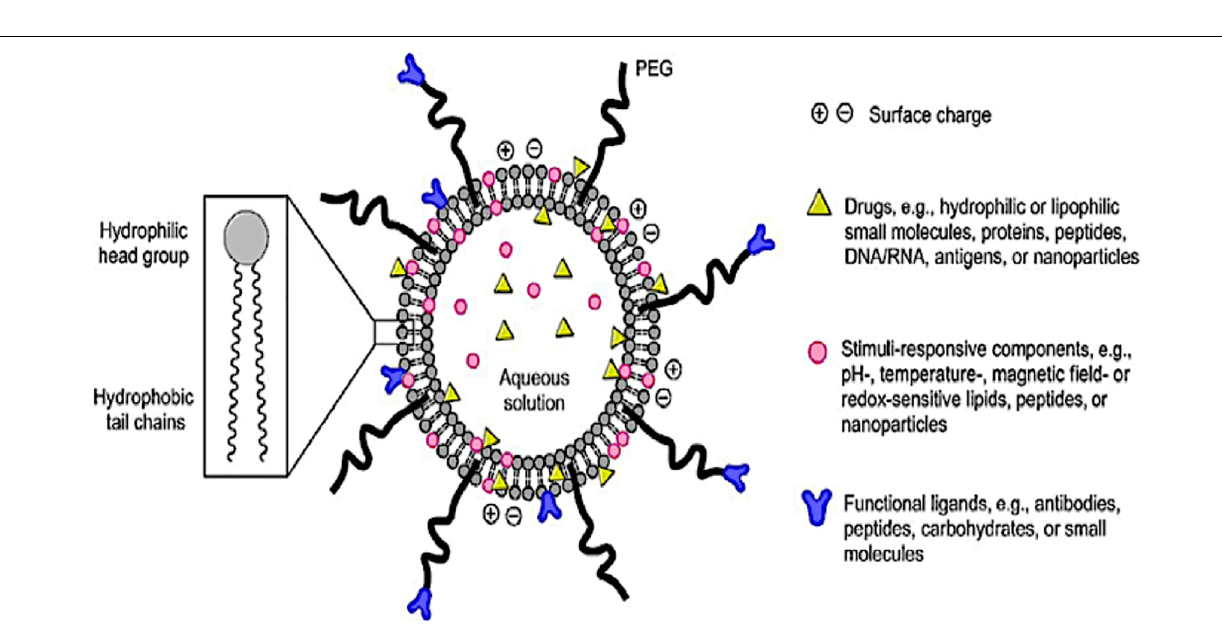
Frontiers in Bioengineering and Biotechnology |